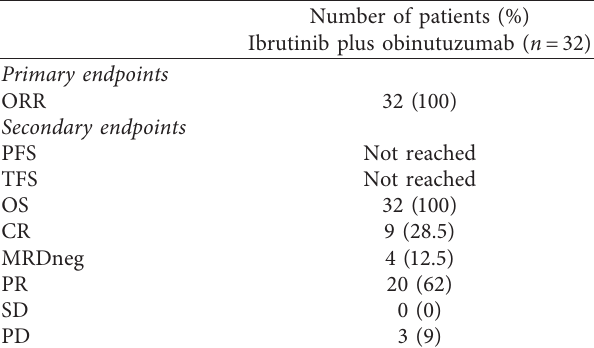
Table 3: Summary of the results.